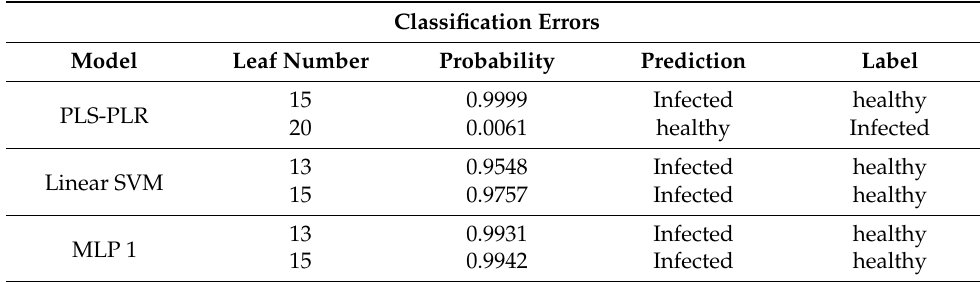
Table 4. Classification errors in external validation